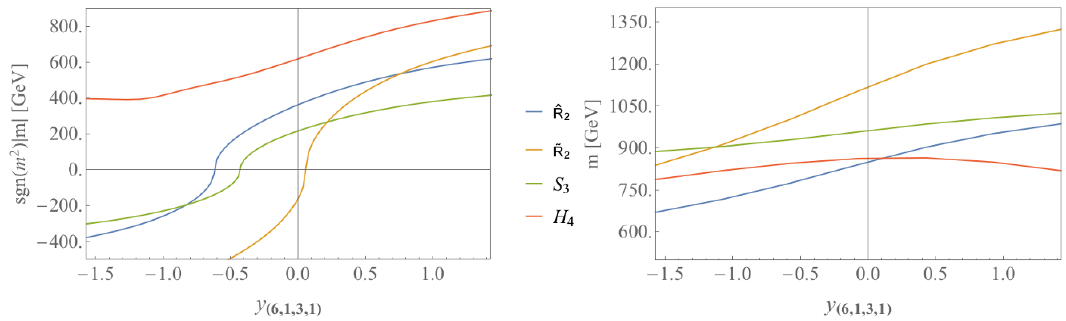
Figure 3 . Plot of leptoquark masses along with m 4 , for two di(cid:11)erent regimes. On the left frame, in a region where the masses squared become negative. We plot the absolute value of the mass, along with the sign of m 2 . On the right frame we plot a region where leptoquark masses are all higher, reaching about a